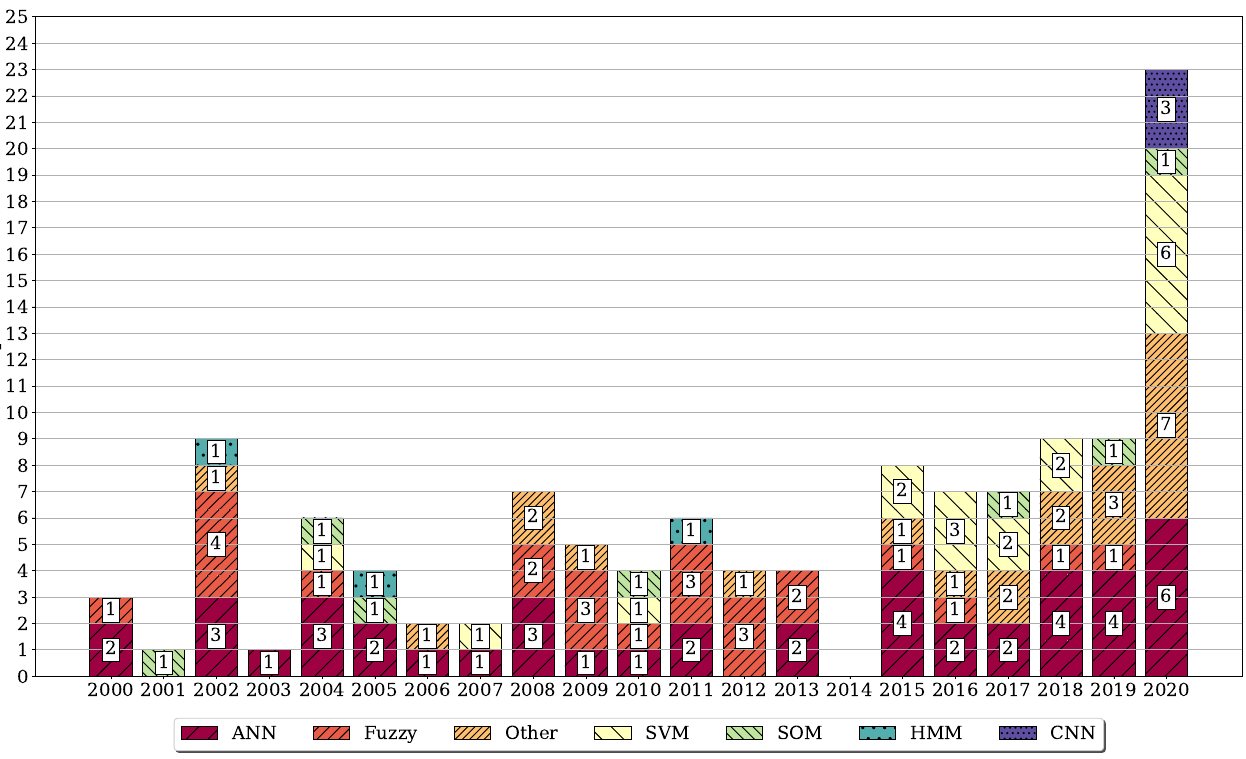
Figure 6. Chronological repartition of the type of AI—Note that some articles present several AI techniques. On average, all identified articles are cited 18 times. Even if the HMM approach is not strongly represented in the literature (Section 4.1), it appears that that publication [32] has been cited a significant number of times. However, this citation analysis may present some